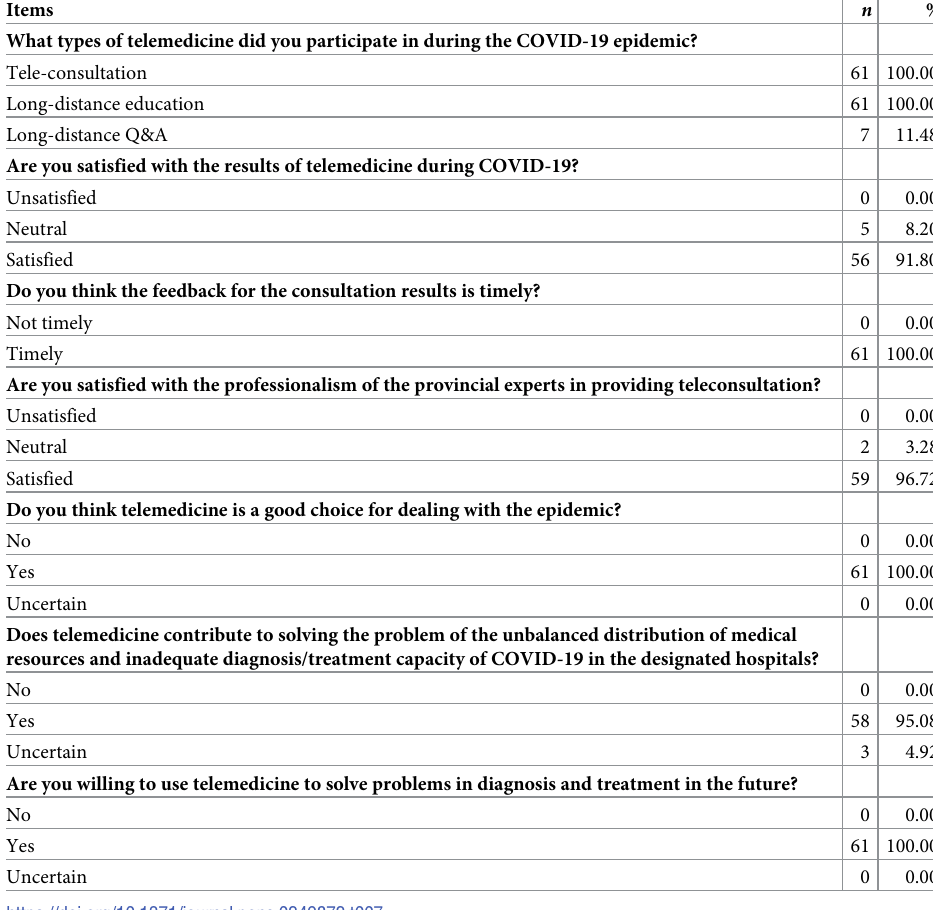
Table 6. The satisfaction survey of provincial experts who had experienced telemedicine in the COVID-19 epi- demic ( n = 23). Items n % What types of telemedicine did you participate in during the COVID-19 epidemic? Remote consultation 23 100.00 Long-distance education 11 47.83 Long-distance Q&A 5 21.74 Do you think that telemedicine was useful during the COVID-19 epidemic? Useless 0 0.00 Useful 23 100.00 Uncertain 0 0.00 What were the benefits of using telemedicine in COVID-19 epidemic? Saved time 23 100.00 Effective use of provincial expert resources 20 86.96